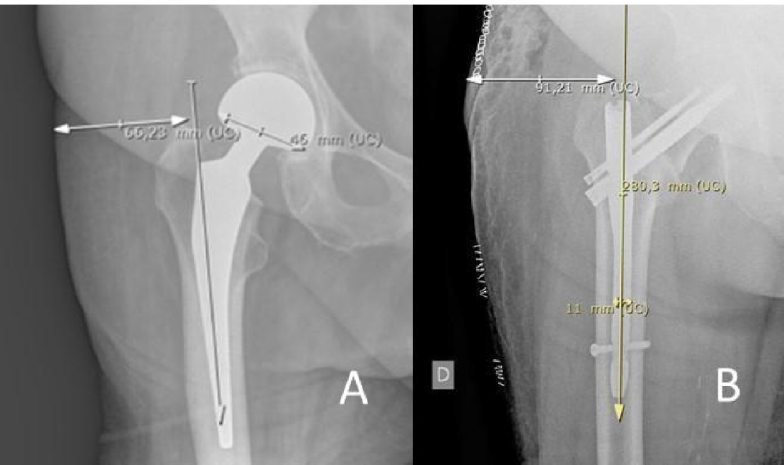
Figure 1. The images above show calibration procedures and subcutaneous radiographic measurement (SRM) assessment. Figure 1A shows measurement for hemiarthroplasty and figure 1B for an IM nail. First, a parallel line to the femoral diaphysis was drawn. In figure 1A, a known measure was introduced as a reference for the dome component (in this case 46mm). In figure 1B, the nail diameter was used as a reference (11mm). Following this calibration procedure, a perpendicular line to the femoral diaphysis was drawn from the tip of the greater trochanter and the distance to the skin from this point was